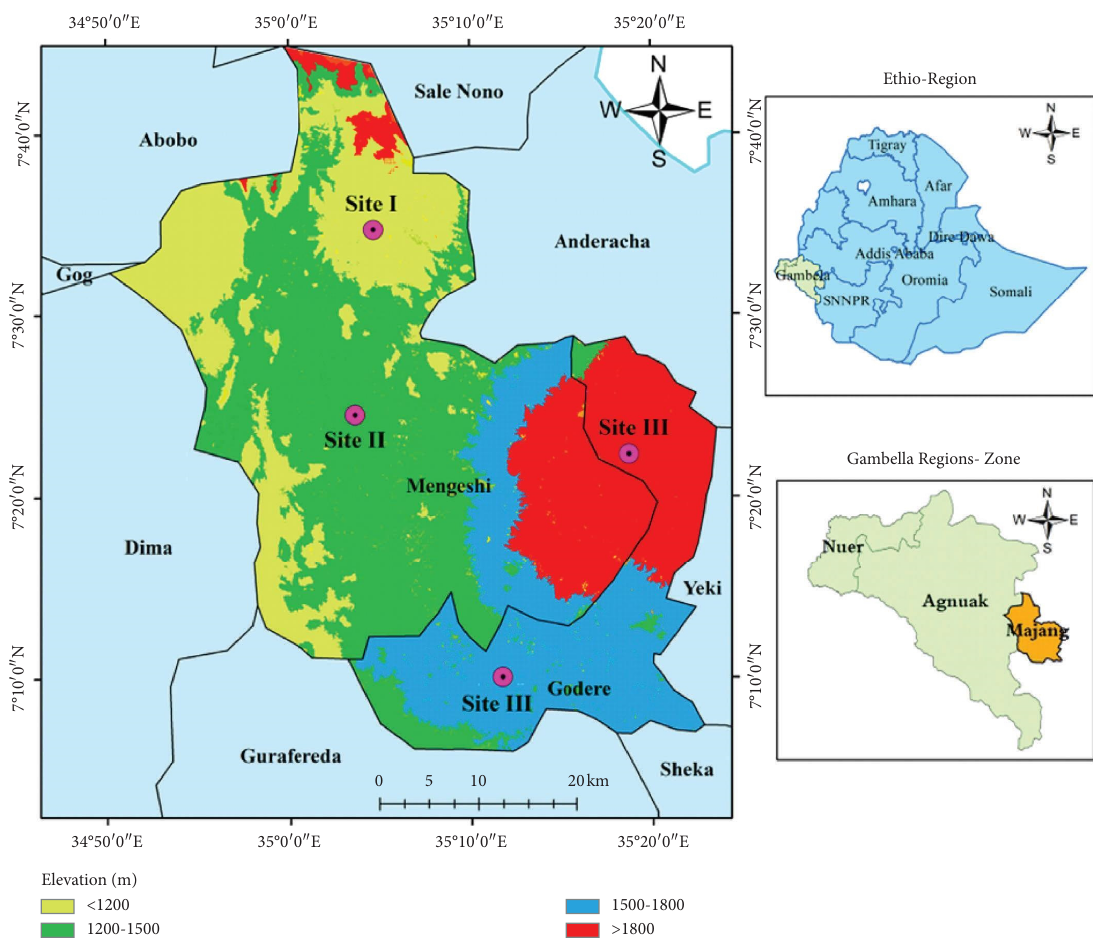
Figure 1: Location of the study sites (sites I–IV). Source: https://earthexplorer.usgs.gov.